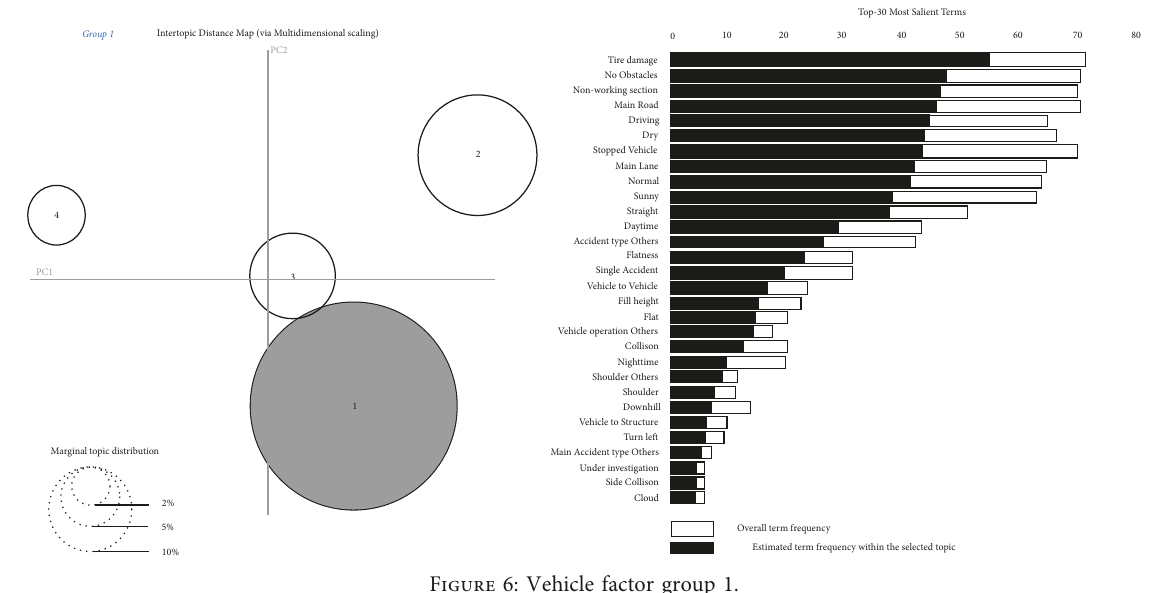
Figure 6: Vehicle factor group 1.